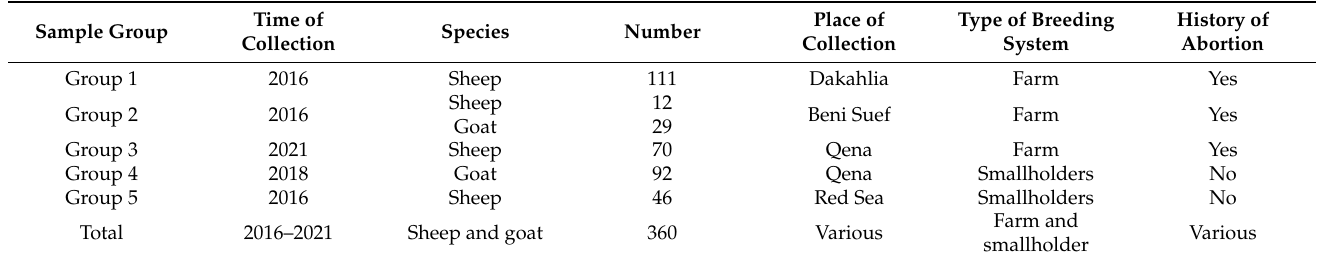
Table 1. Sample information and history of